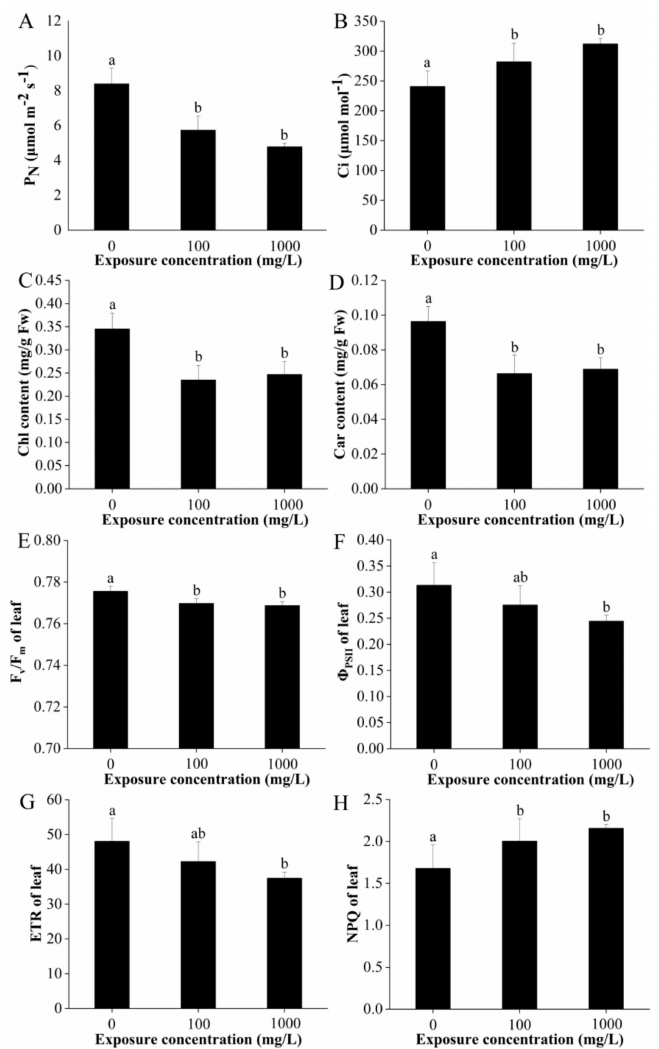
Figure 2. Gas exchange parameters (net photosynthesis ( A ), intercellular carbon dioxide concentra- tion ( B ), total chlorophyll ( C ), and carotenoids ( D ) content, and chlorophyll fluorescence parameters (potential efficiency of PSII photochemistry (F v /F m , E ), effective quantum yield of PSII ( Φ PSII , F ), electron transport rate (ETR, G ), and non-photochemical fluorescence quenching (NPQ, H )) of lettuce after 15 days of foliar exposure to CuO-NPs (0, 100, and 1000 mg/L). Values are expressed as the mean of five replicates ( ± SD) for each treatment; the different lowercase letters (a and b) indicate significant difference at p < 0.05 among different exposure concentrations, mean values with the same letter are not significantly